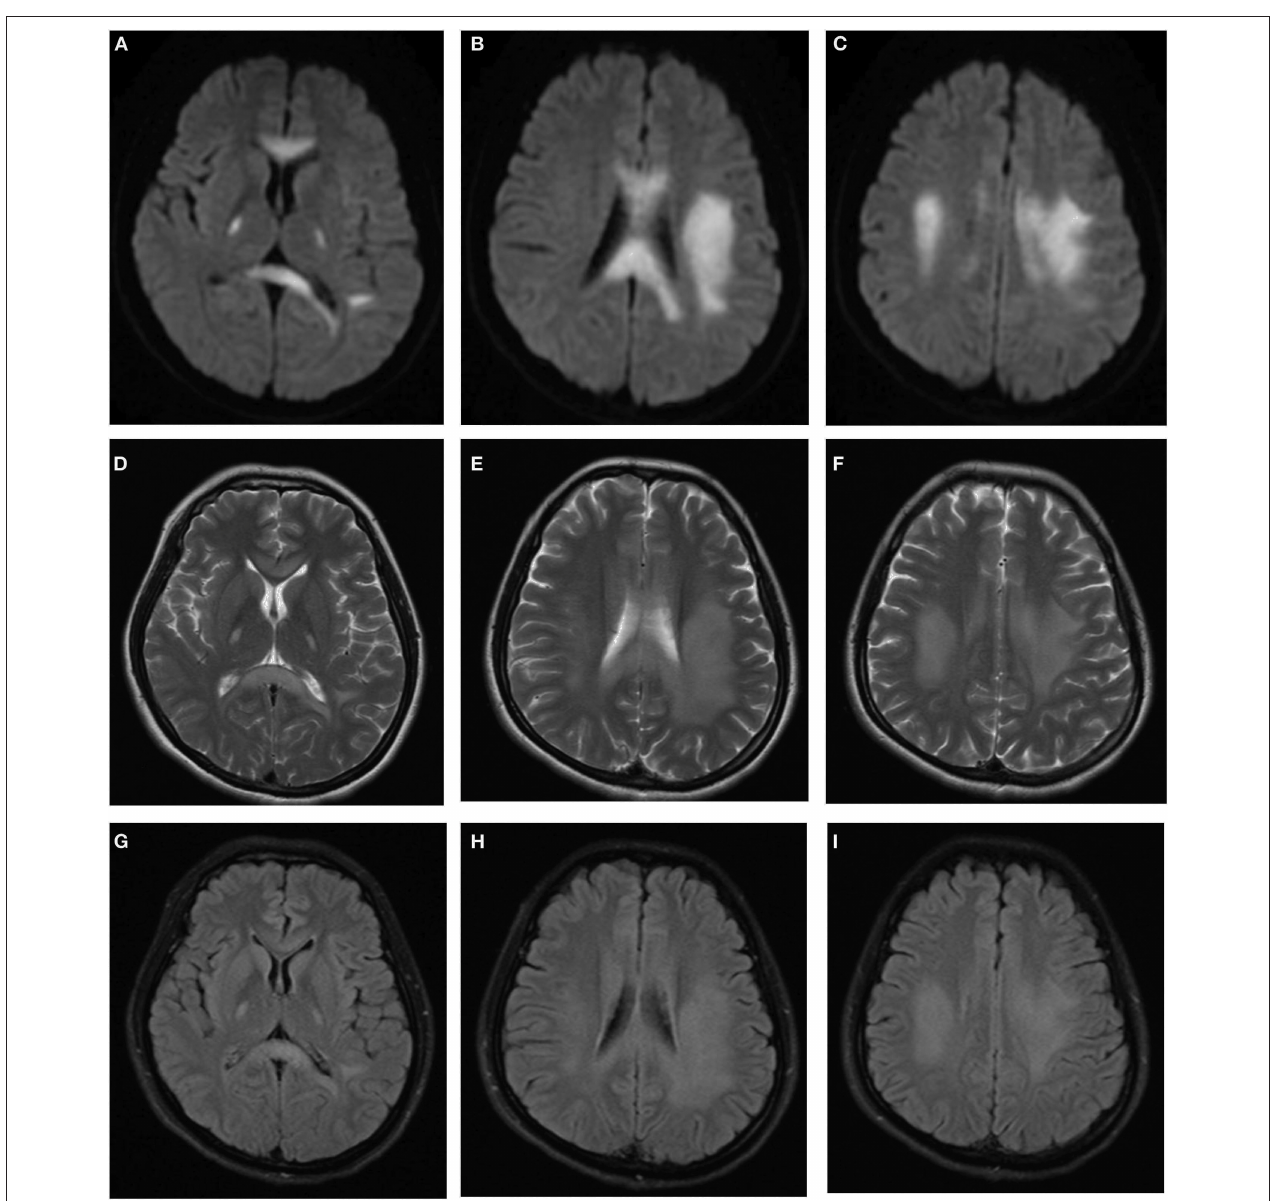
FIGURE 1 | Brain MRI indicated diffuse abnormal signals in corpus callosum, posterior limbs of bilateral internal capsule, and centrum semiovale. (A–C) Diffusion weighted imaging. (D–F) T2-weighted imaging. (G–I) FLAIR